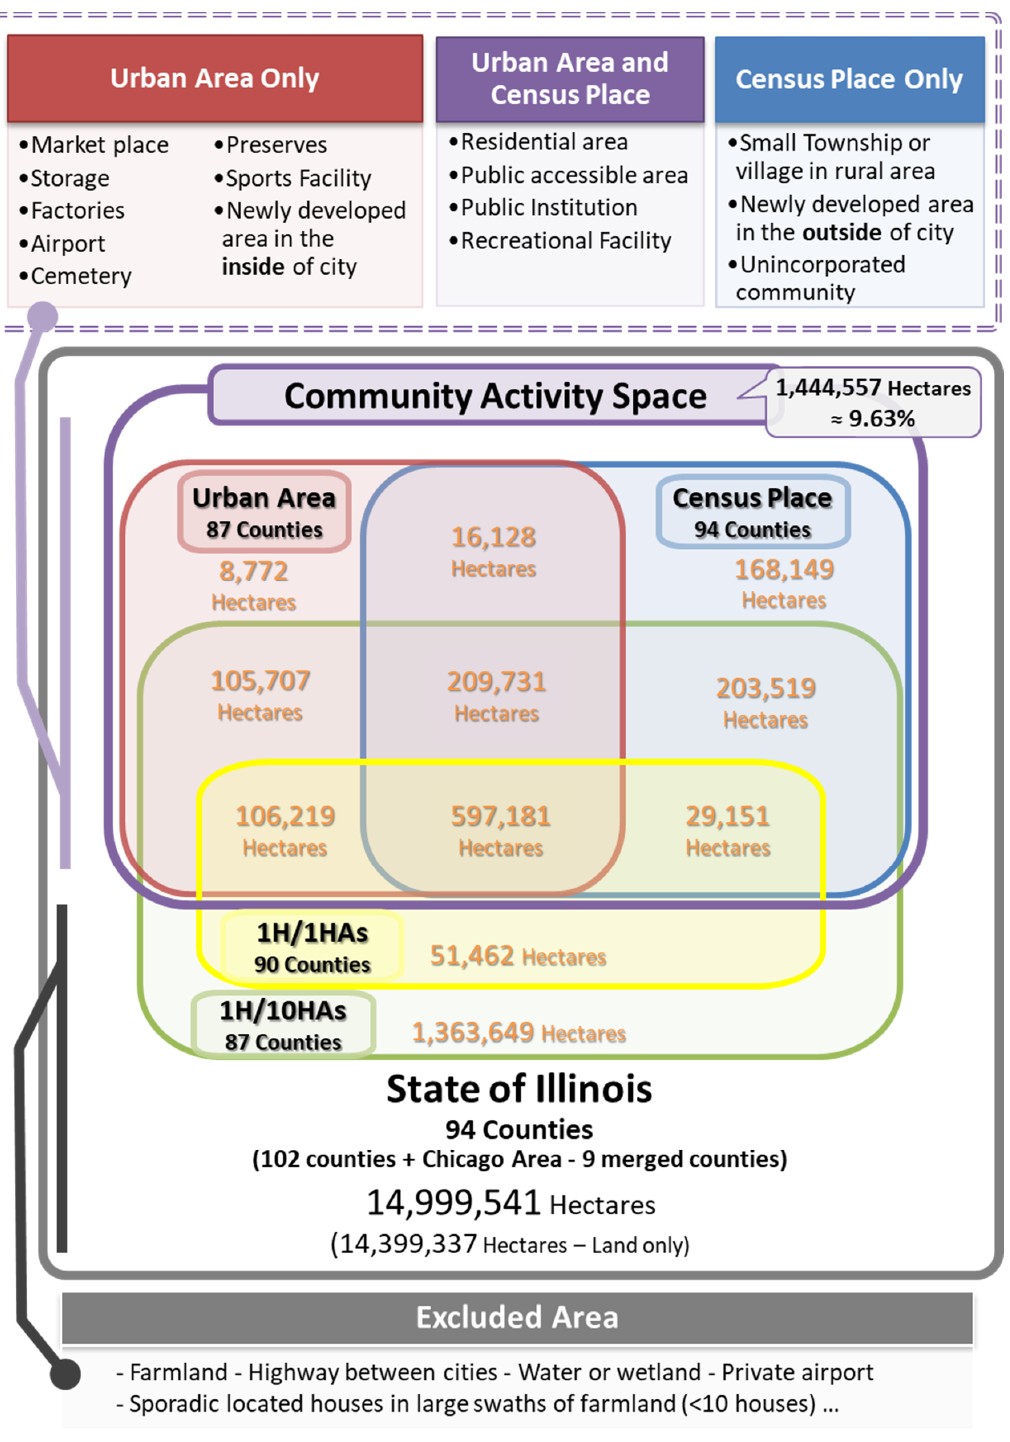
Figure 4. Geographical and contextual information among various spatial boundaries to determine community activity space for community green space measurement in Illinois.